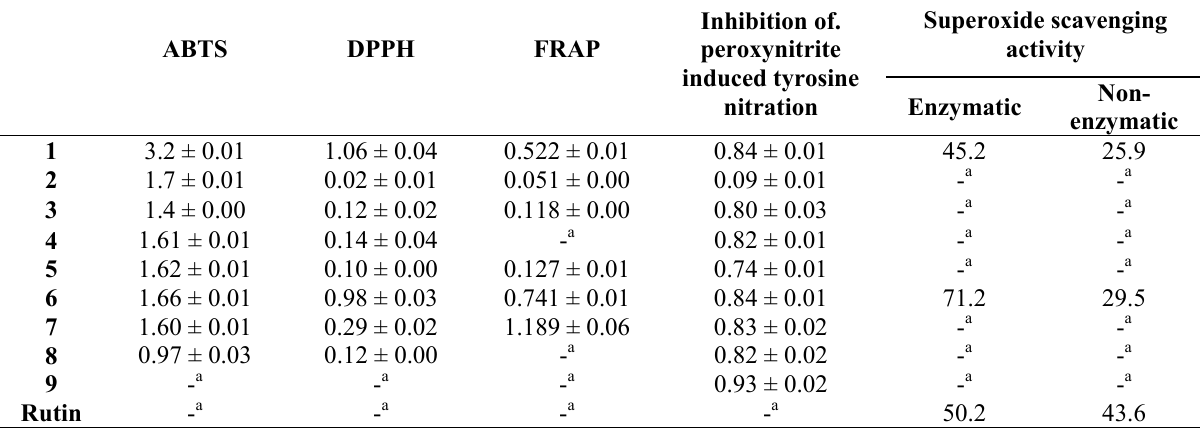
Table 2. Antioxidant activities of compounds 1 - 9 determined by using ABTS, DPPH, FRAP, the inhibition of tyrosine nitration (activity expressed as TEAC - ability of the sample to scavenge the radical relative to the radical scavenging ability of Trolox ® . Value are multiples of activity of Trolox ® ) and superoxide scavenging activity (expressed as % of inhibition at 50 μ M